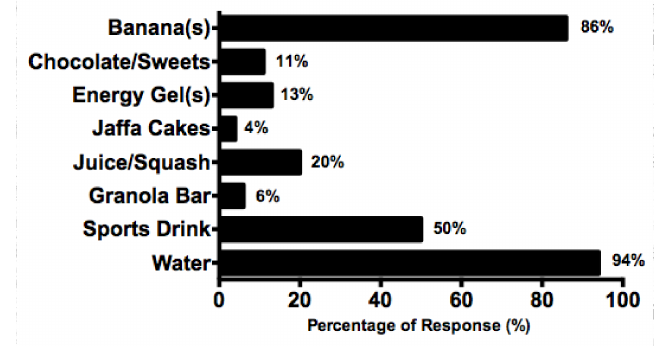
Figure 1. Match-Play nutrition consumption, expressed as percentages. Other responses included the consumption of figs, dates, branched chain amino acids (BCAAs), a cube of jelly, and homemade fruit cupcakes; all cited once by different